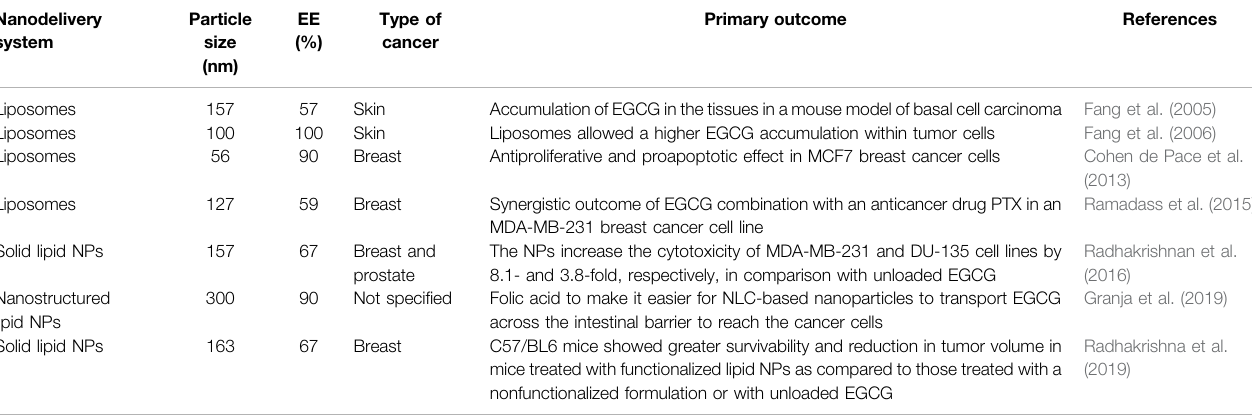
TABLE 1 | Lipid-based NPs, including liposomes and lipid NPs, as EGCG delivery systems. Nanodelivery